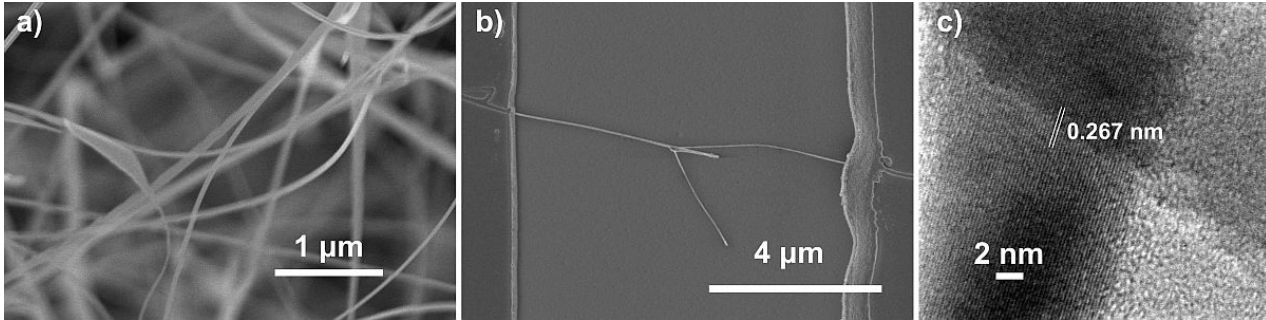
Figure 1. ( a ) SEM image of the SnO 2 nanowires grown by CVD (magnification 30 k); ( b ) SEM image of the sensor: a single SnO 2 nanowire bridging the metallic electrodes on the sides (magnification 12 k); ( c ) TEM image of two crossing nanowires.